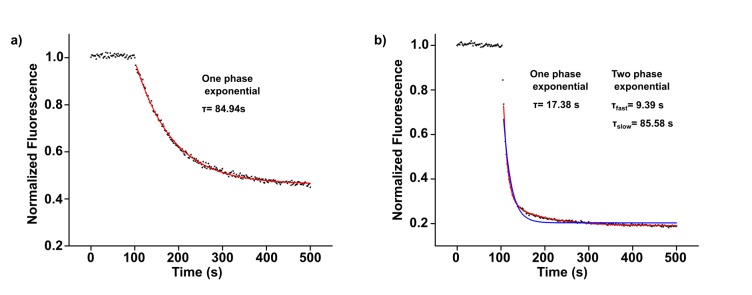
Examples of fluorescence quenching fits with exponential equations.(a) KtrAB-ATP flux assay representative curve with sorbitol in the external solution. Fit was performed using a one-phase exponential equation: y=y0+A1e-(x-x0)/τ (red line). (b) KtrAB-ATP flux assay representative curve with sorbitol in the external solution and in the presence of 2 mM magnesium. Fit was performed using a two-phase exponential equation: y=y0+A1e-(x-x0)/τfast+A2e-(x-x0)/τslow (red line). Attempt of fitting with a one phase exponential equation is shown as a blue line.